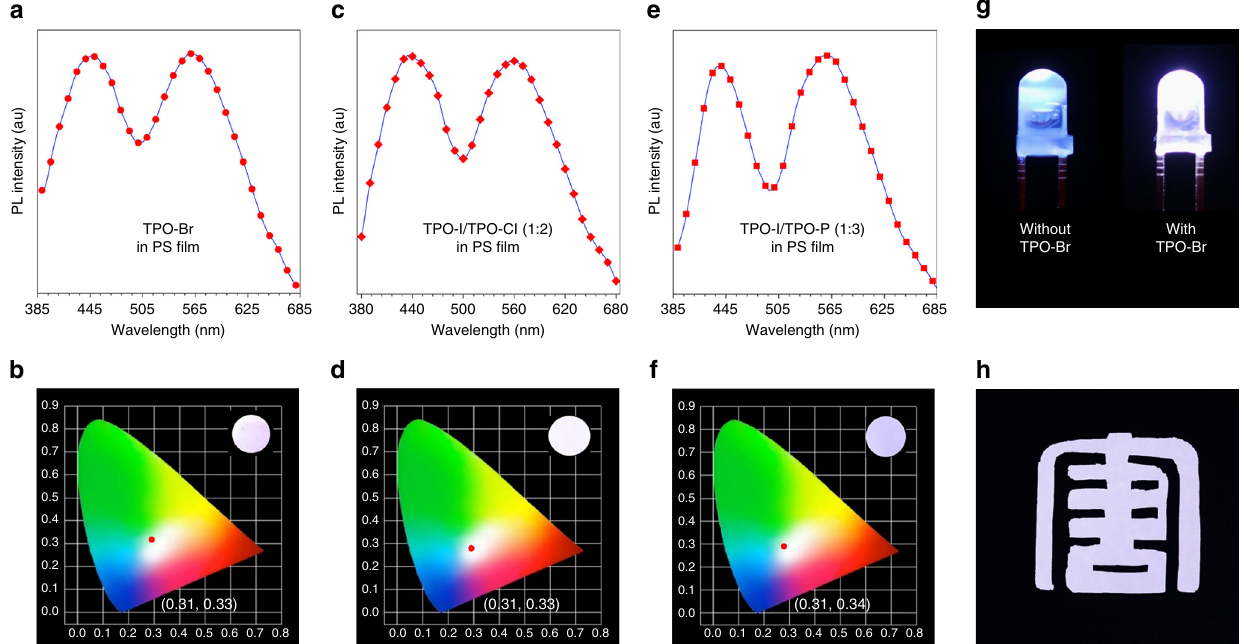
Fig. 5 White light emitters in polystyrene (PS) fi lms based on organic salts. PL spectra and CIE 1931 coordinates of prompt emission of a , b TPO-Br, c , d TPO-I/TPO-Cl (molar ratio = 1:2), and e , f TPO-I/TPO-P (molar ratio = 1:3) in polystyrene (PS) (2%, m/m). Insets show luminescent photographs of these PS fi lms taken under 365 nm UV irradiation. g Luminescent photographs of UV-LED lamps (Emission wavelength: 360 – 370 nm) coated with PS fi lms without (left) and with (right) TPO-Br. h Luminescent pattern of a Chinese character “ Tang ” based on the PS fi lm (3 cm × 3 cm) containing TPO-Br (2%, m/m) taken under 365 nm UV